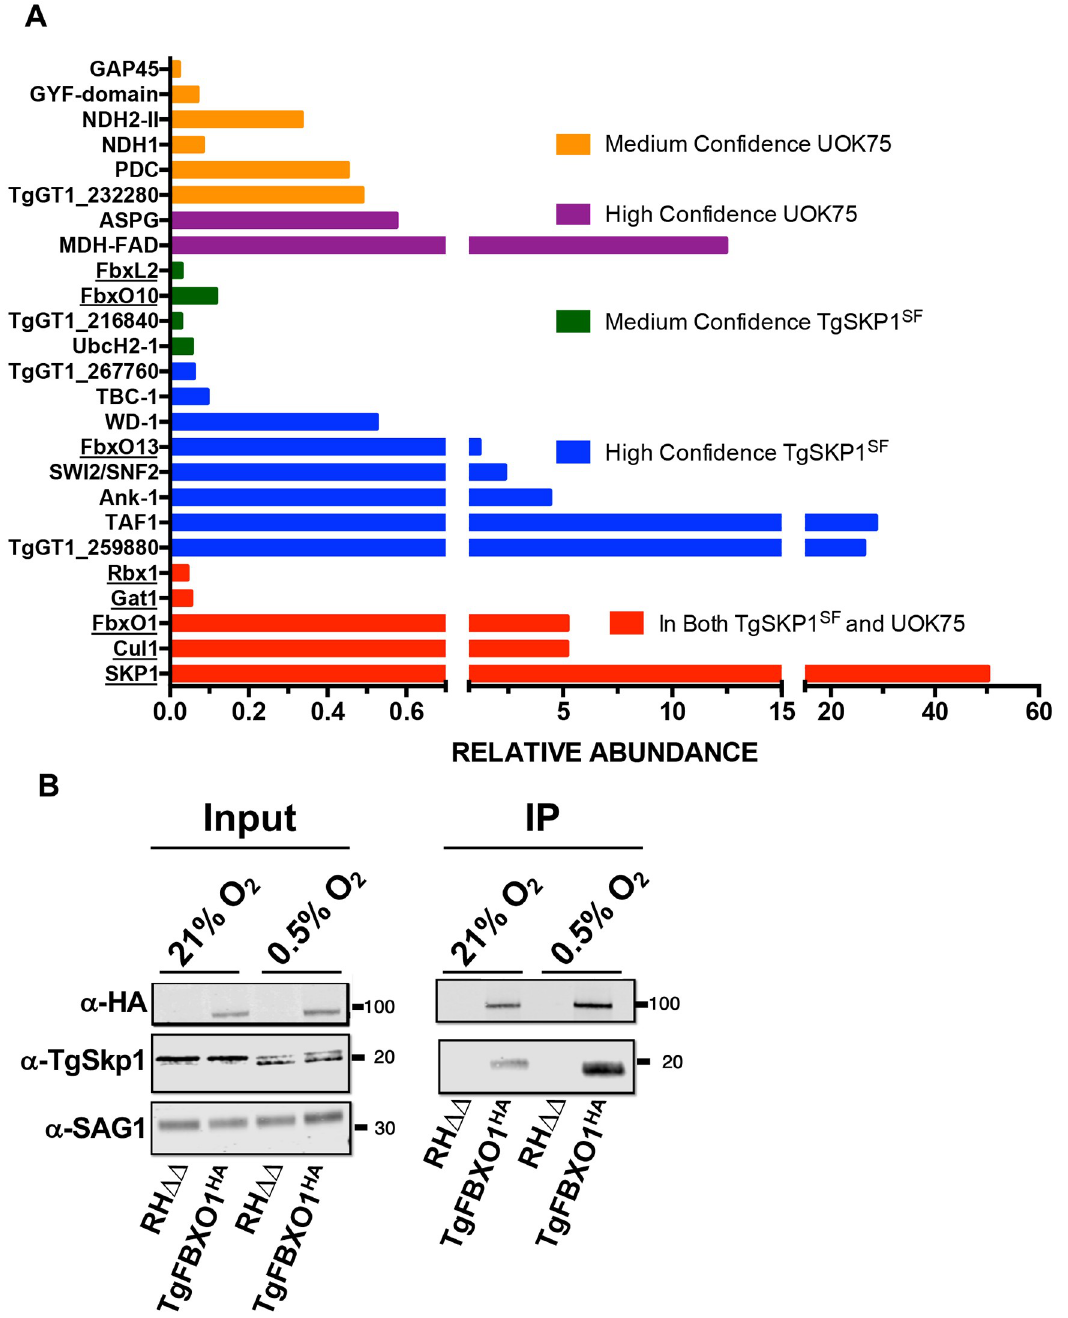
Fig 1. TgFBXO1 interacts with TgSKP1. (A) . RH Δ hxgprt Δ Ku80 and TgSKP1 SF tachyzoites were solubilized and immunoprecipitated with affinity purified anti-TgSKP1 (UOK75) or anti-FLAG (M2), respectively. The immunoprecipitates were trypsin digested and subjected to proteomic analysis. Protein candidates were selected from a list of protein hits that were detected in multiple replicates and minimally recovered with irrelevant antibodies (for UOK75) or the untagged strain (for M2), and are reported as found in either both (red bars) or only individual immunoprecipitations with either high or medium confidence. Proteins known or predicted to interact with TgSKP1 are underlined. See S2 Fig and S2 Table for origin of protein labels and more information about control data. (B) . Lysates prepared from TgFBXO1 HA and parental RH Δ hxgprt Δ Ku80 grown at 21% or 0.5% O 2 were either Western blotted (Input) or incubated with anti-HA antibodies (IP). The immunoprecipitates were captured by Protein G Sepharose and the immune complexes were Western blotted to detect TgFBXO1 HA , TgSkp1, and SAG1.